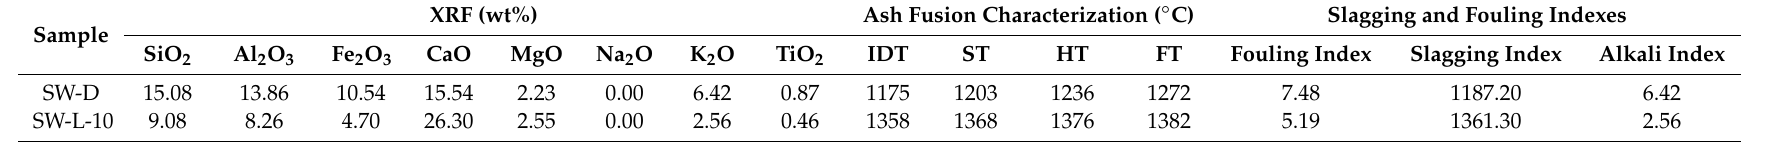
Table 3. Ash chemical components and ash fusion characterization of SW-D and SW-L-10.